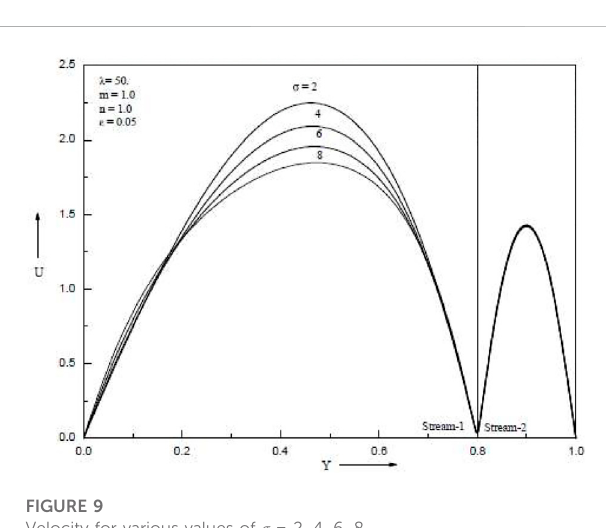
FIGURE 7 Temperature for various values of σ = 2, 4, 6, 8.